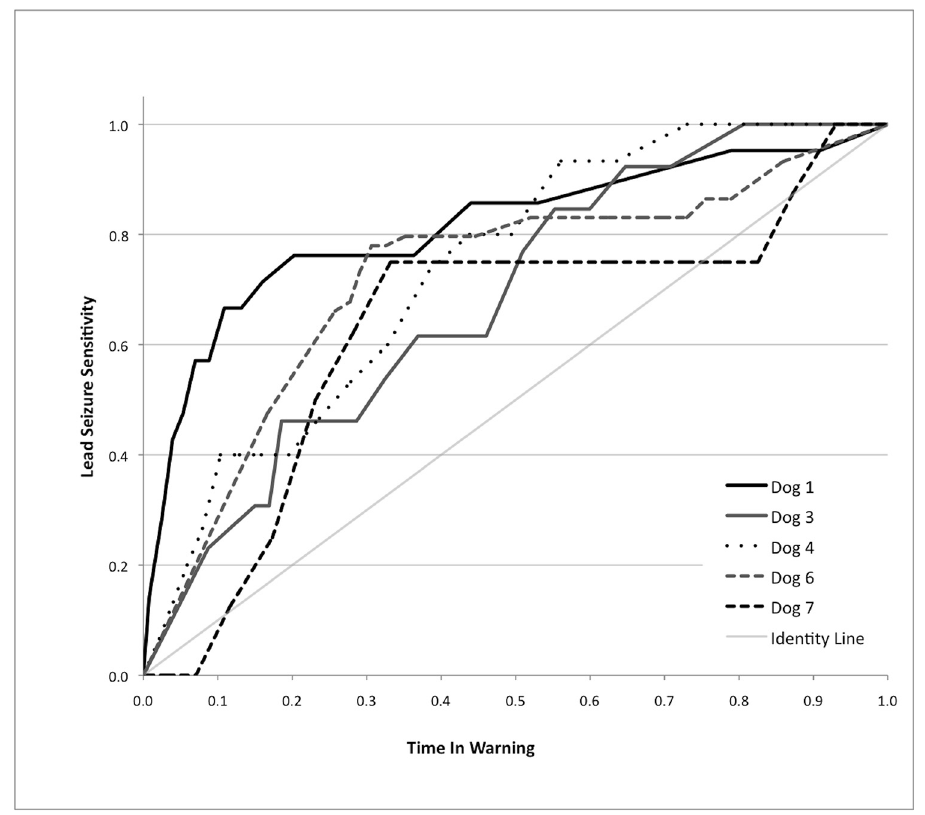
Fig 2. Receiver-operating characteristic curves for the five analyzed canines. Curves were generated by varying the threshold required to initiate a seizure warning.